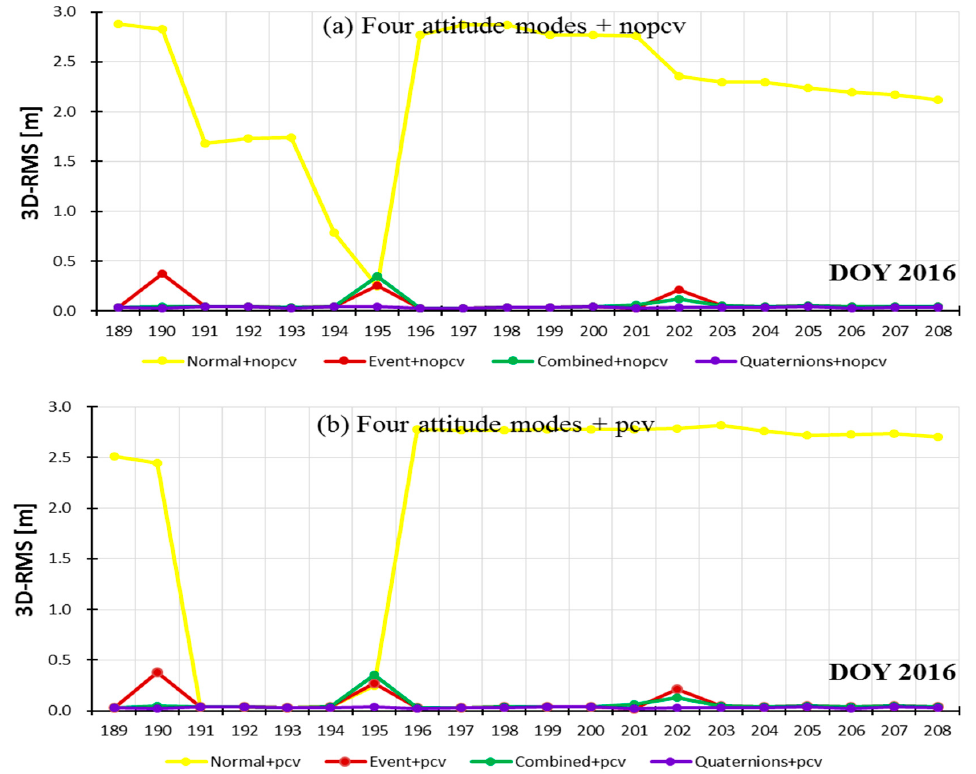
Figure 11. Accuracy comparison of the eight schemes according to with/no PCV.